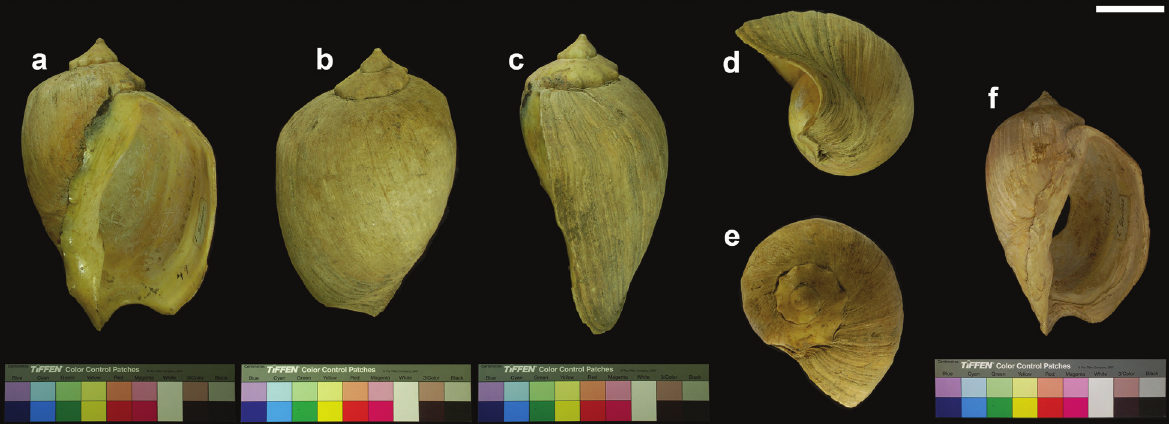
Figure 32. Voluta colocynthis globosa . a–e Specimen figured by Lahille (1895: pl. V, fig. 49) a Apertural view b Dorsal view c Lateral view d Umbilical view e Apical view f Specimen figured by Lahille (1895: pl. I, fig. 3) in apertural view. Scale bar: 5 cm.